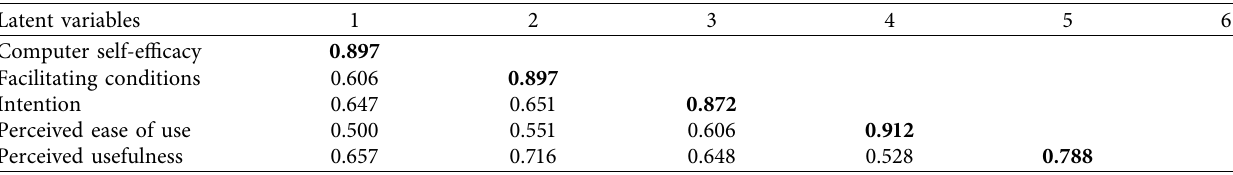
Figure 2: Measurement model. Table 4: Discriminant